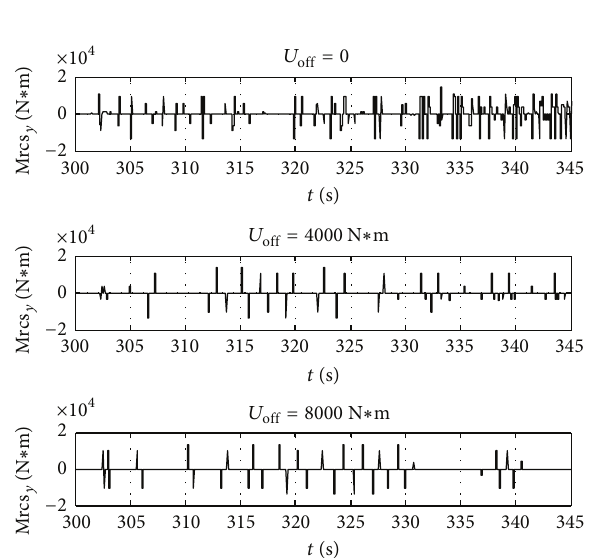
Figure 31: Simulation result of RCS